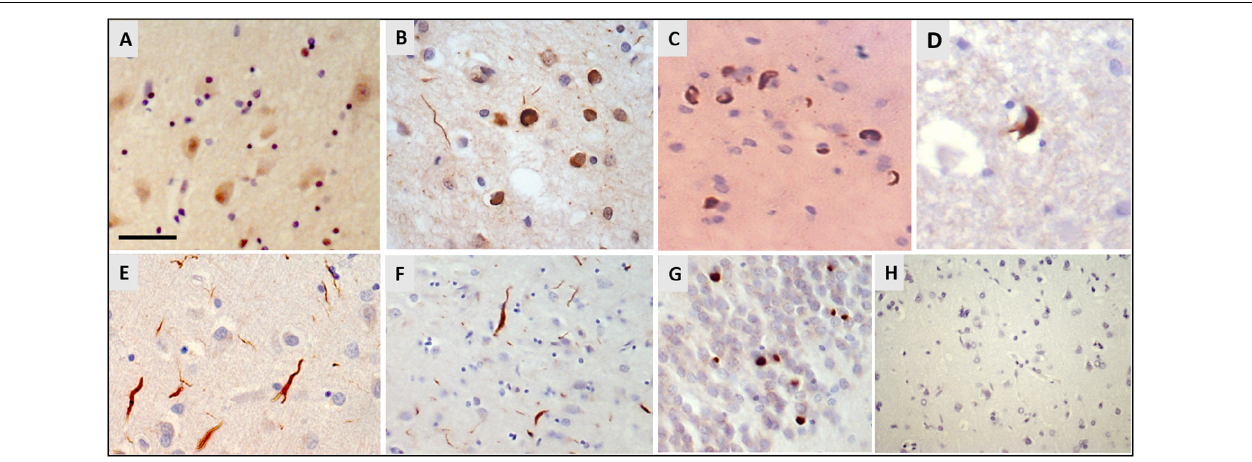
FIGURE 1 | Immunohistochemistry for hnRNP E2. (A) Weak cytoplasmic staining and stronger nuclear staining is seen in the frontal cortex of a control case (case ID BBN_16256). (B–D) Sections from a FTLD-TDP subtype A case showed numerous perinuclear cytoplasmic neuronal inclusions and frequent dystrophic neurites, mainly in layer 2 of the frontal cortex (B) . Similar cytoplasmic inclusions were detected in hippocampal neurons (C) and sparsely in the anterior horn of the spinal cord (D) (case ID BBN_15298). (E–G) In FTLD-TDP subtype C there were frequent long dystrophic neurites in the superficial layers of the frontal cortex (E) and in the hippocampus (F) . Within the granular cells of the dentate fascia round intracellular inclusions were seen (G) (case ID BBN_15303). (H) No inclusions were seen in the frontal cortex of the subtype D case (H) . Scale bar represents 20 µ m in panels (A,B,E) ; 80 µ m in panels (C,D,G) ; 100 µ m in panel (F,H) .